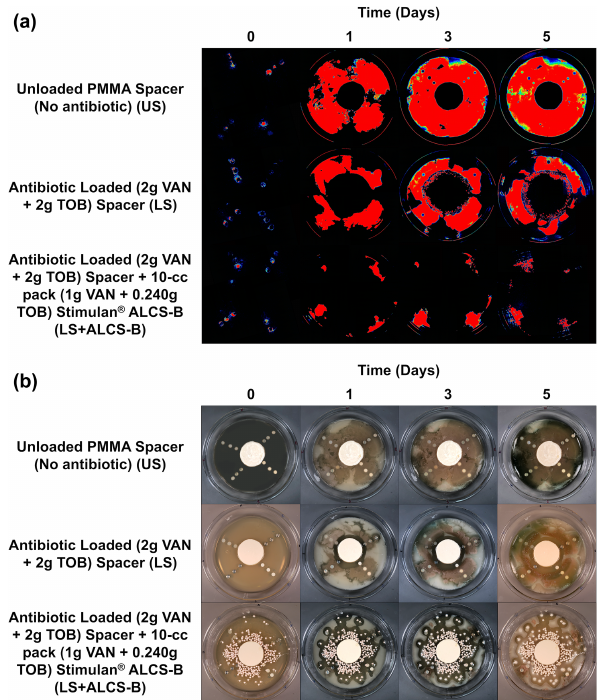
Figure 2. IVIS (a) and white-light (b) images tracking the suppres- sion of P. aeruginosa Xen41 biofilm spread from biofilm-colonized discs of four different orthopedic materials for three different an- tibiotic conditions. Plates were imaged every 24h for 5d. At the periphery of all plates, there is a loss of bioluminescence over time, even in the non-antibiotic control. This is likely due to nutrient de- pletion and a loss of metabolic activity in this